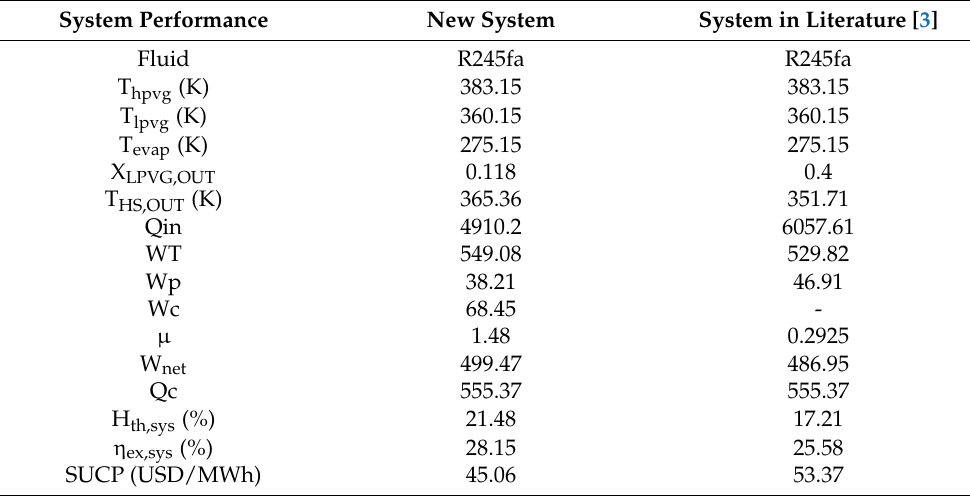
Table 14. Comparison between the thermodynamic performance of the system in this study and that of the reference